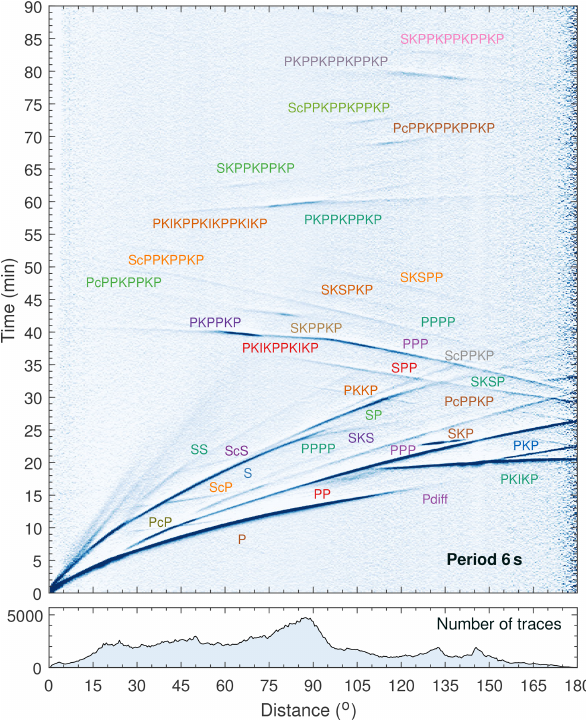
Figure 7. Global stacks of the vertical components of the seismo- grams selected from over 2500 shallow earthquakes (event depth ≤ 50km and magnitude ≥ 5 . 4) occurring between 1995 and 2013. The seismograms are filtered around 6s period and converted into traces of STA / LTA ratios. The STA / LTA traces are binned by epi- central distances at an interval of 0.5 ◦ and normalized for plotting. More details can be found on the IRIS Data Services Products web- site.